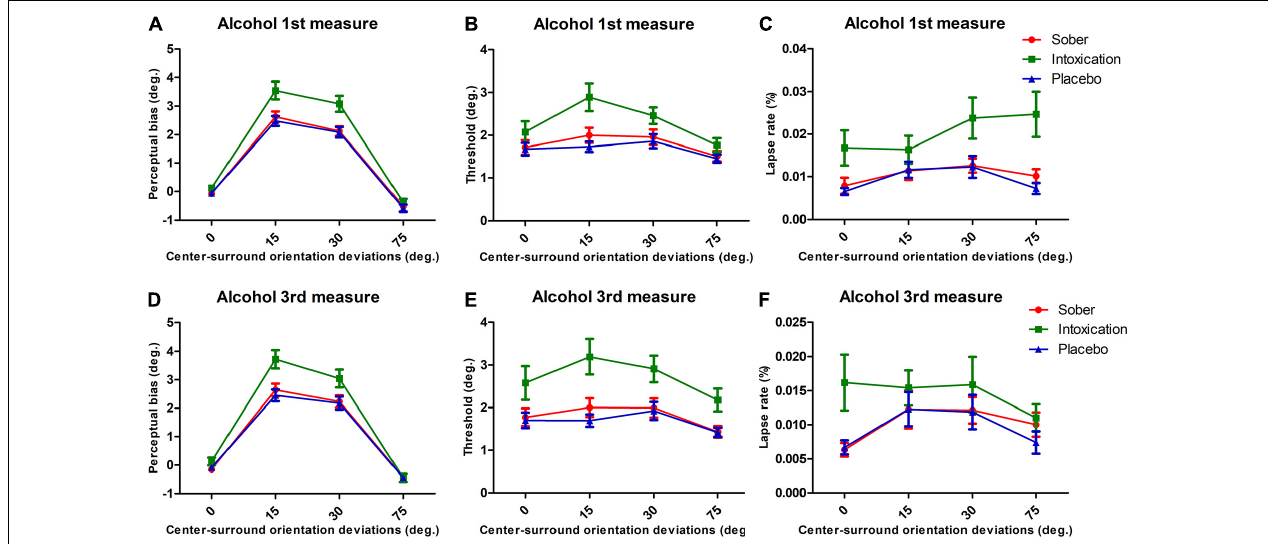
FIGURE 3 | Results for bias, threshold, and lapse rates for 1st and 3rd measurements of alcohol. Same format as Figure 2